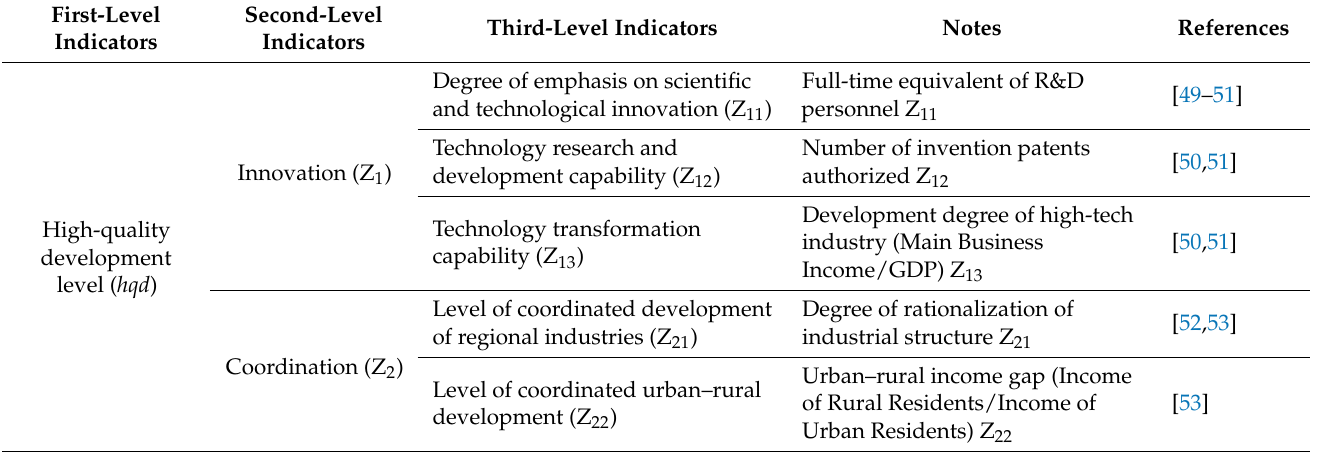
Table 1. Index of high-quality development